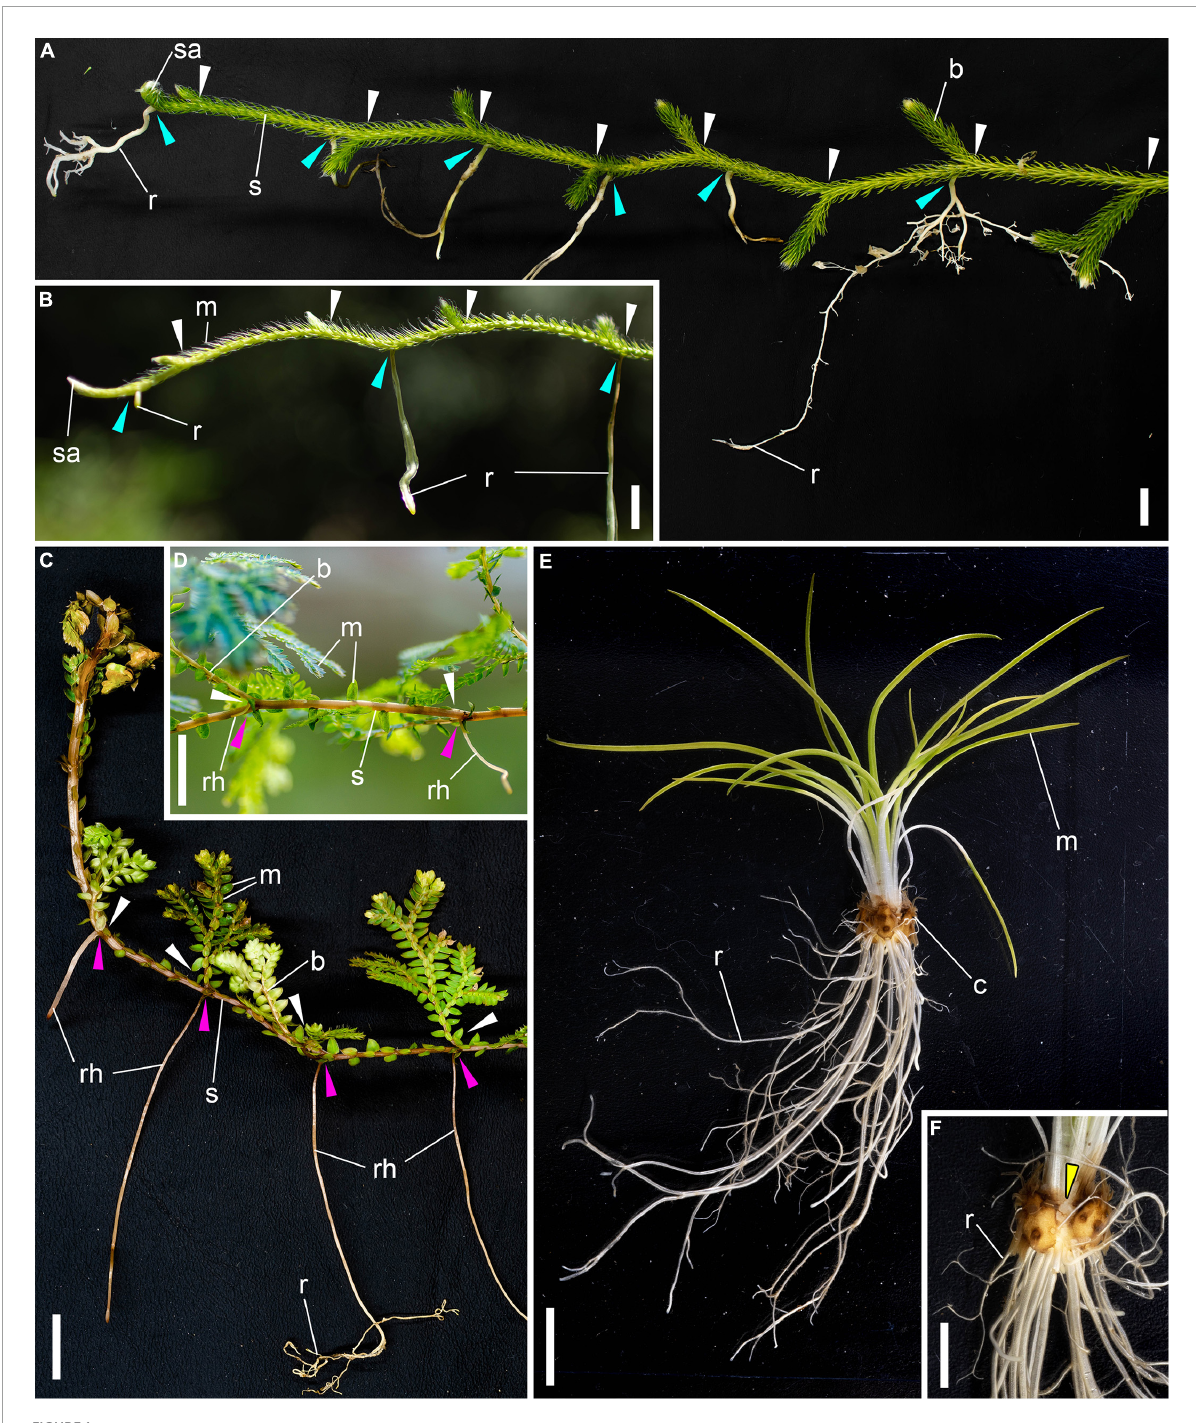
FIGURE1 Body architectures of extant lycophytes. (A,B) Lycopodium clavatum (Lycopodiaceae). (A) Dorsal view. (B) Lateral view. White arrows: dichotomies of shoots; blue arrows: emergence positions of roots endogenously from parent shoot. (C,D) Selaginella uncinata (Desv. ex Poir.) Spring (Selaginellaceae). Lateral views. White arrows: dichotomies of shoots; pink arrows: exogenous branching points of rhizophores. (E,F) Isoetes pseudojaponica M.Takamiya, Mitsu.Watan. et K.Ono (Isoetaceae). (E) Lateral view. (F) The opposite side of (E) . Yellow arrow: furrow of corm. b, lateral branch (shoot); c, corm; m: microphyll; r, root (rootlets in Isoetes ); rh, rhizophore; s, shoot (main axis); sa, shoot apex. Scale bars, 10 mm in (A–E) , 5 mm in (F)